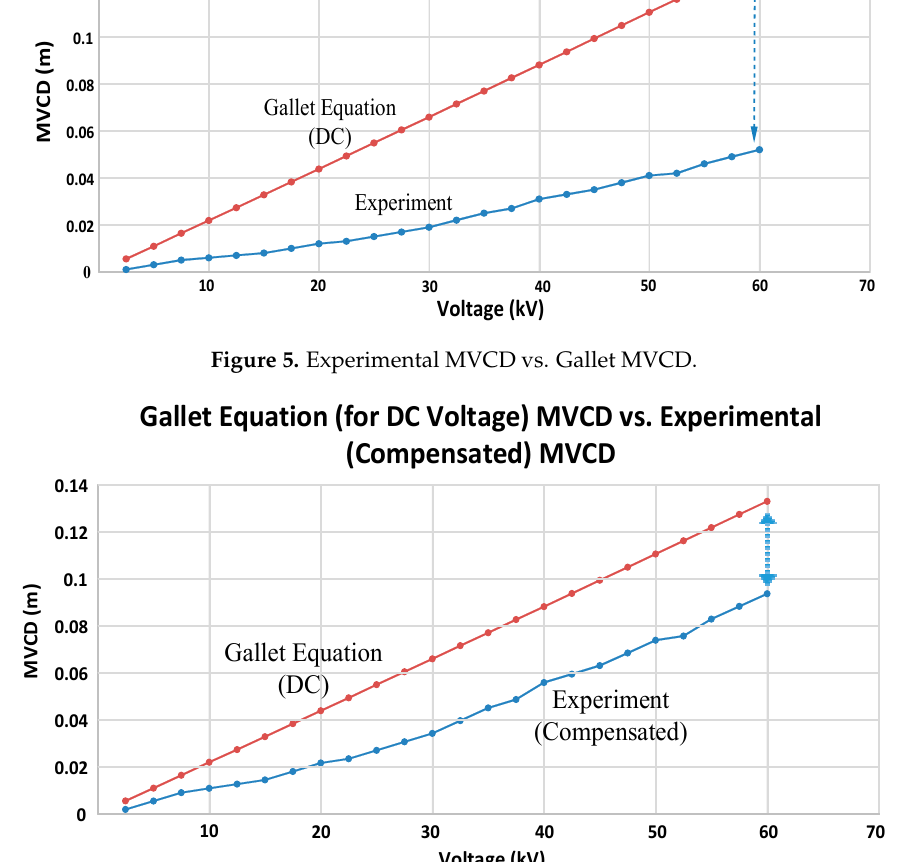
Figure 6. Experimental (Compensated) MVCD vs. Gallet MVCD.